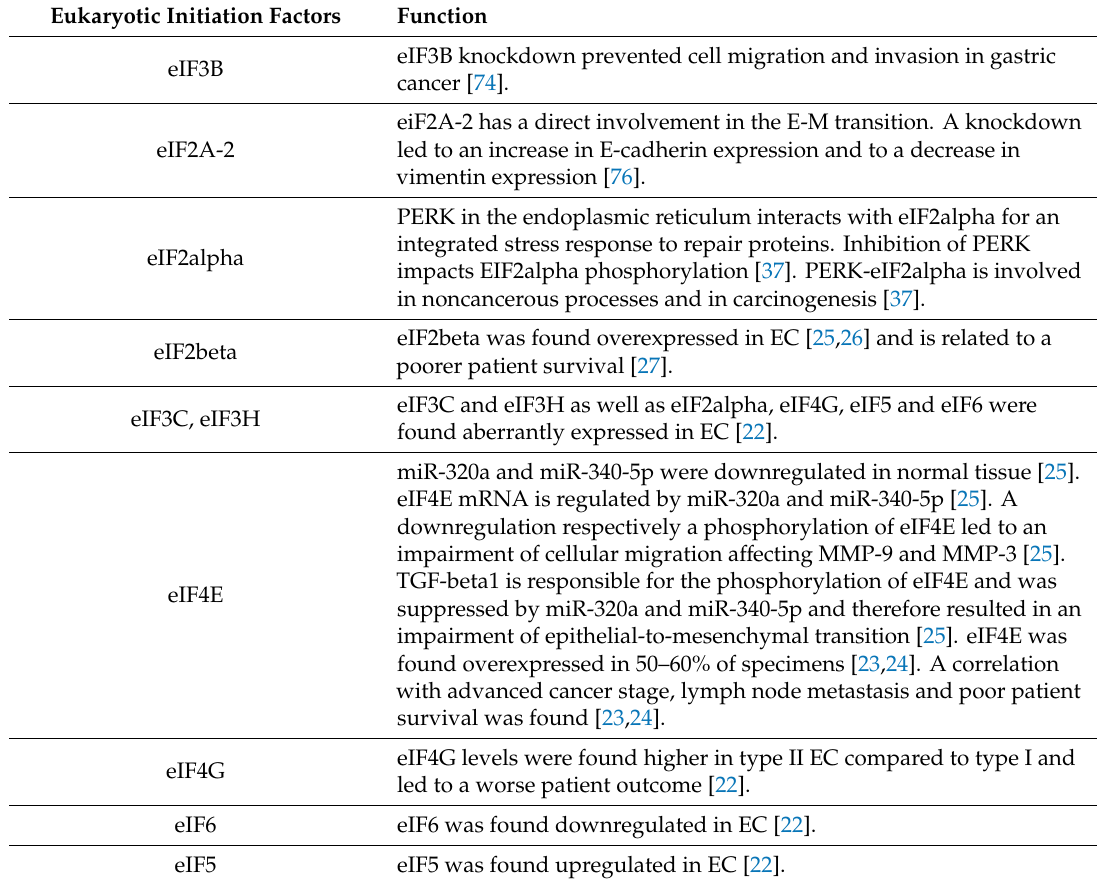
Table 3. The eIFs connected to